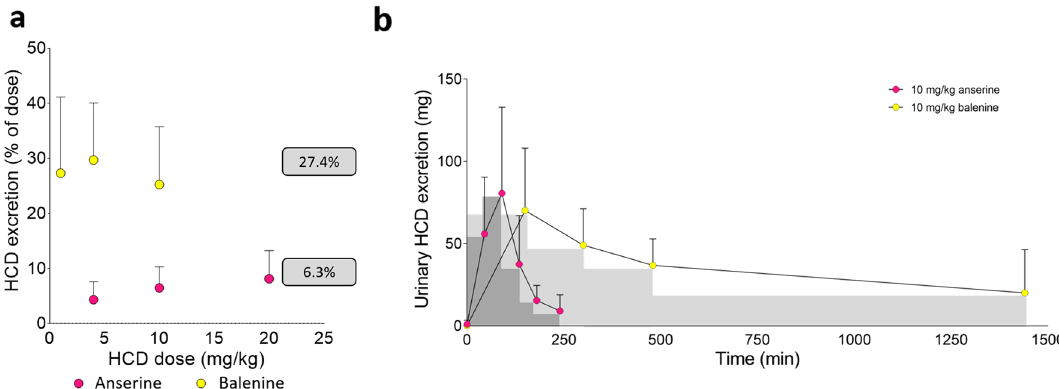
Figure 4. Comparison of the percentage of the dose anserine (n = 7) 20 and balenine (n = 6) that is excreted intact in the urine ( A ). Urine concentration time profile following ingestion of 10 mg/kg anserine 20 or balenine ( B ). Mean ± SD are